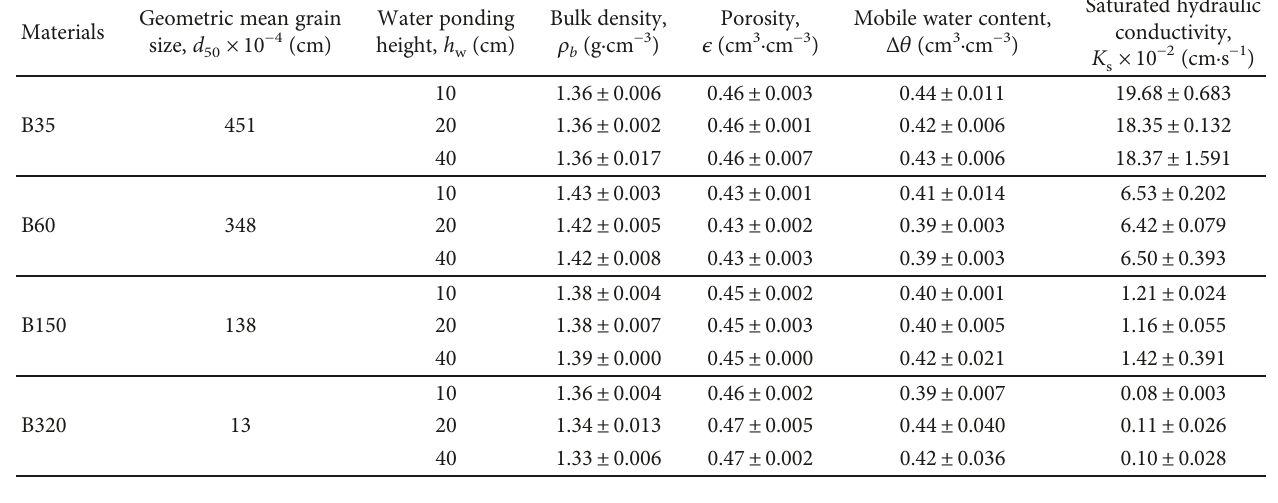
Table 1: Geometric mean grain size, porosity, bulk density, and saturated hydraulic conductivity for column experiments with di ff erent ponding heights.